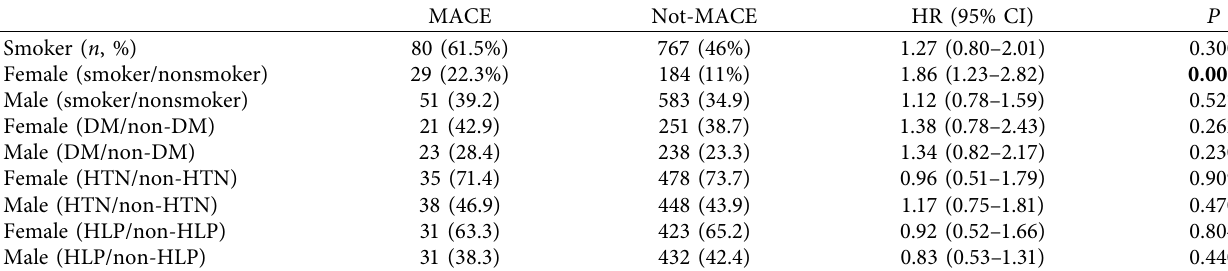
Table 3: Joint effect of smoking with gender and other risk